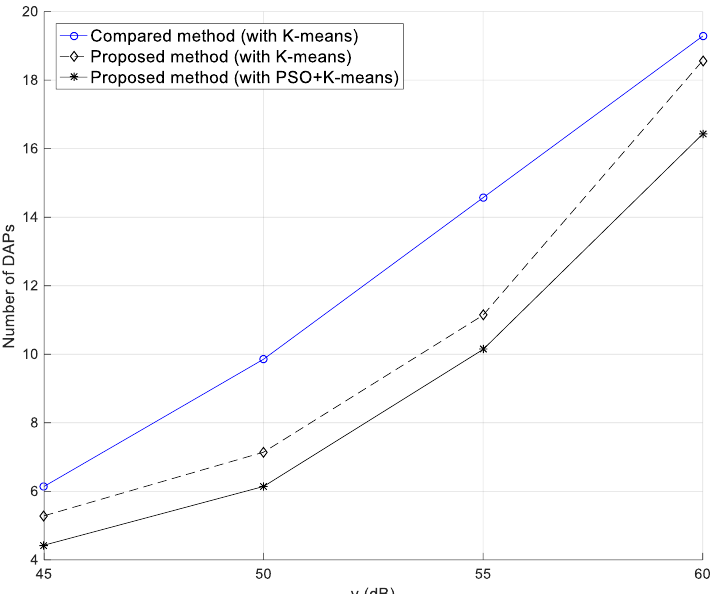
Figure 10. The relationship of the required number of DAPs with SNR threshold ( γ ).